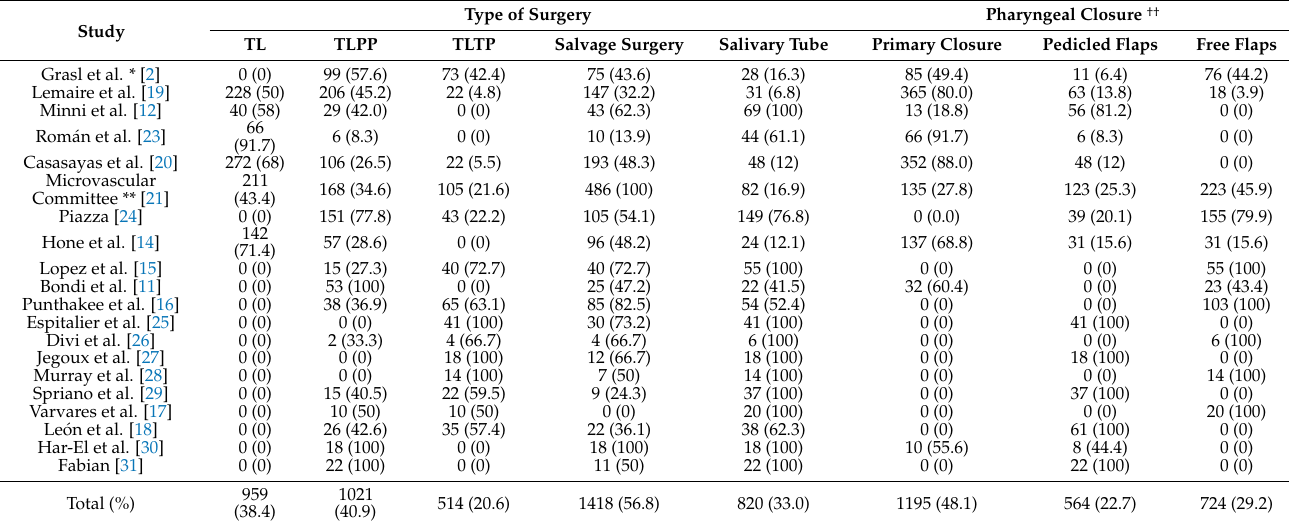
Table 2. Surgical and reconstructive